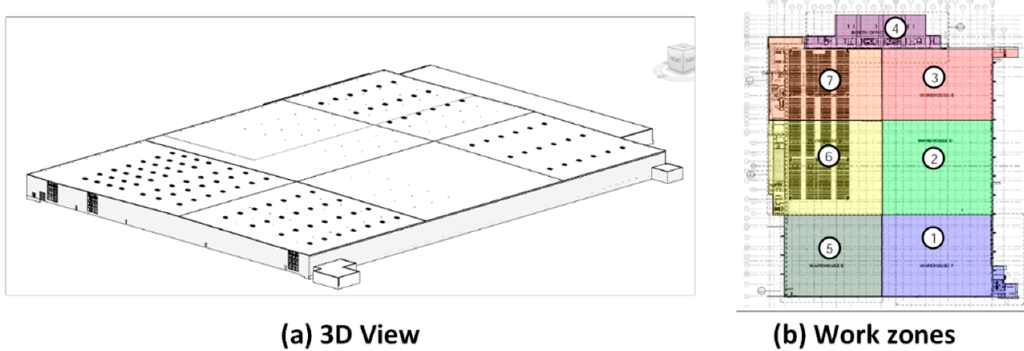
Figure 4. ( a ) BIM model and ( b ) work zones of case study project.